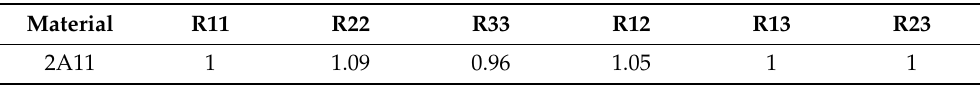
Table 2. Ratio of anisotropic yield stress of materials.